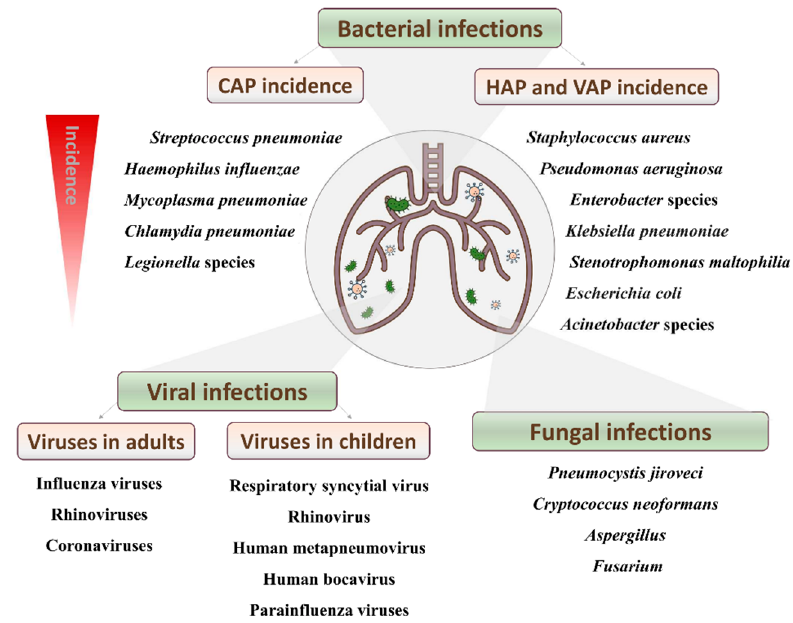
Figure 1. Main pathogens causing pneumonia and their incidence.